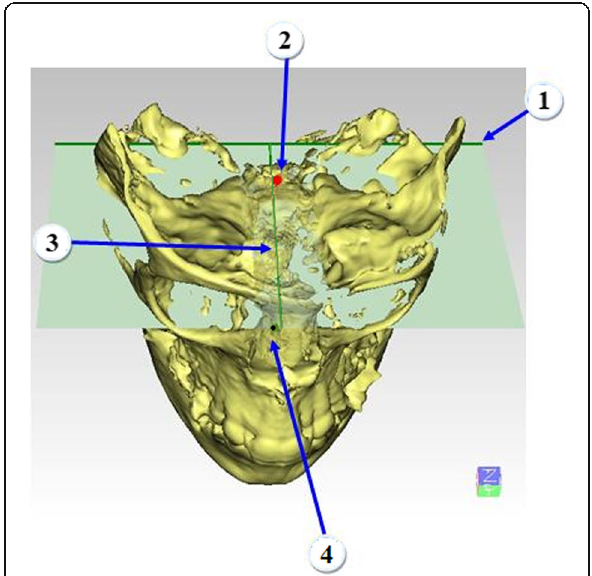
Fig. 2 C-FH:1, Porion axis; 2, C-Sella; 3, Midline; 4, Mid Orbital